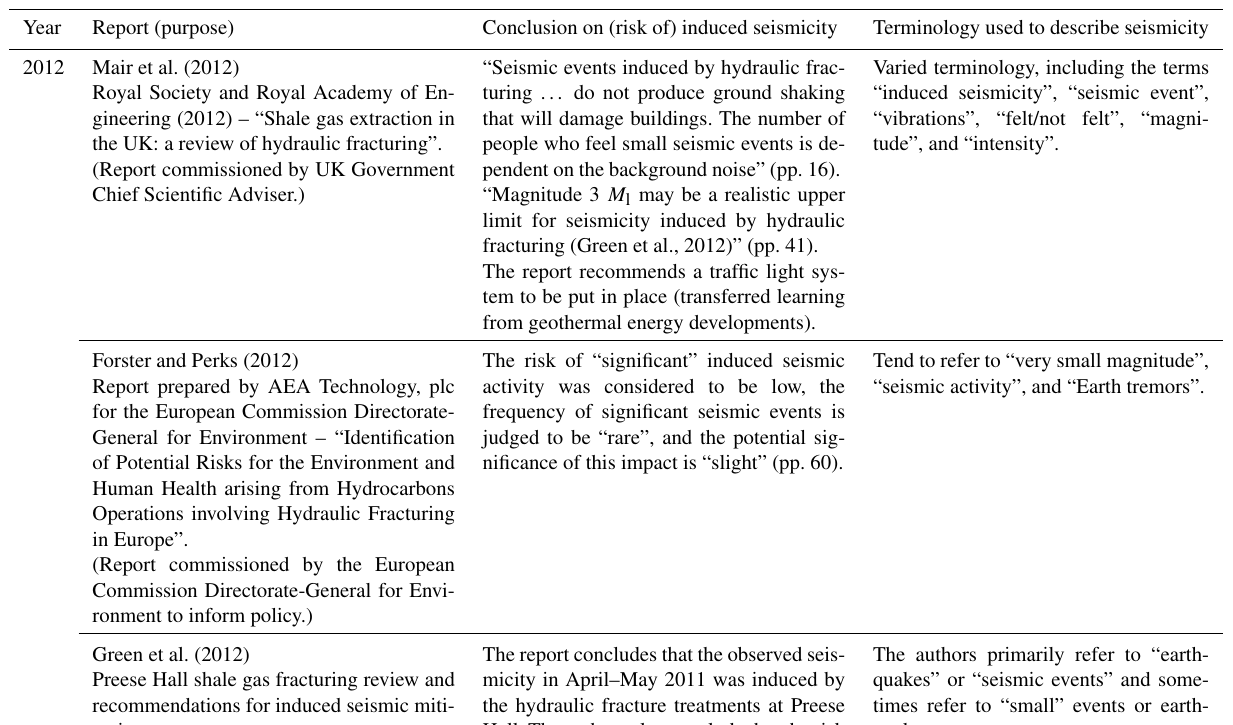
Table 1. A compilation of publicly available expert reports on hydraulic fracturing for shale gas which address induced seismicity, the key conclusion regarding risks of induced seismicity, and the phrasing used in the reports to refer to seismicity. While we primarily examine policy-facing reports from the UK, we include examples from EU policy, Australia, and the